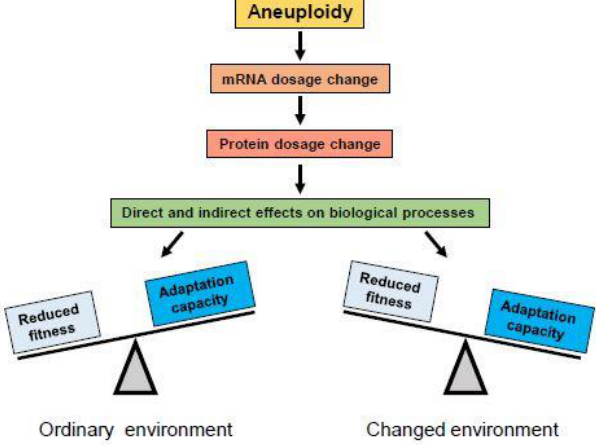
Figure 2. Aneuploidy produces changes in mRNA dosage which lead to changes in protein dosage for genes on the gained or lost chromosome(s). Changed protein levels can have direct effects on biological processes in which they are involved, or change the stoichiometry of protein complexes of which they are components, causing changes in their function. Changes in gene dosage of regulatory proteins like transcription factors may also exert indirect effects on biological processes by altering expression of their target genes on other chromosomes. In most cases, alterations in protein levels are disadvantageous or detrimental for organisms adapted to their ordinary environment (left), where the euploid karyotype provides best fitness. However, under conditions of environmental change, rapid alterations in expression of many genes may provide adaptive potential and be selected (right).